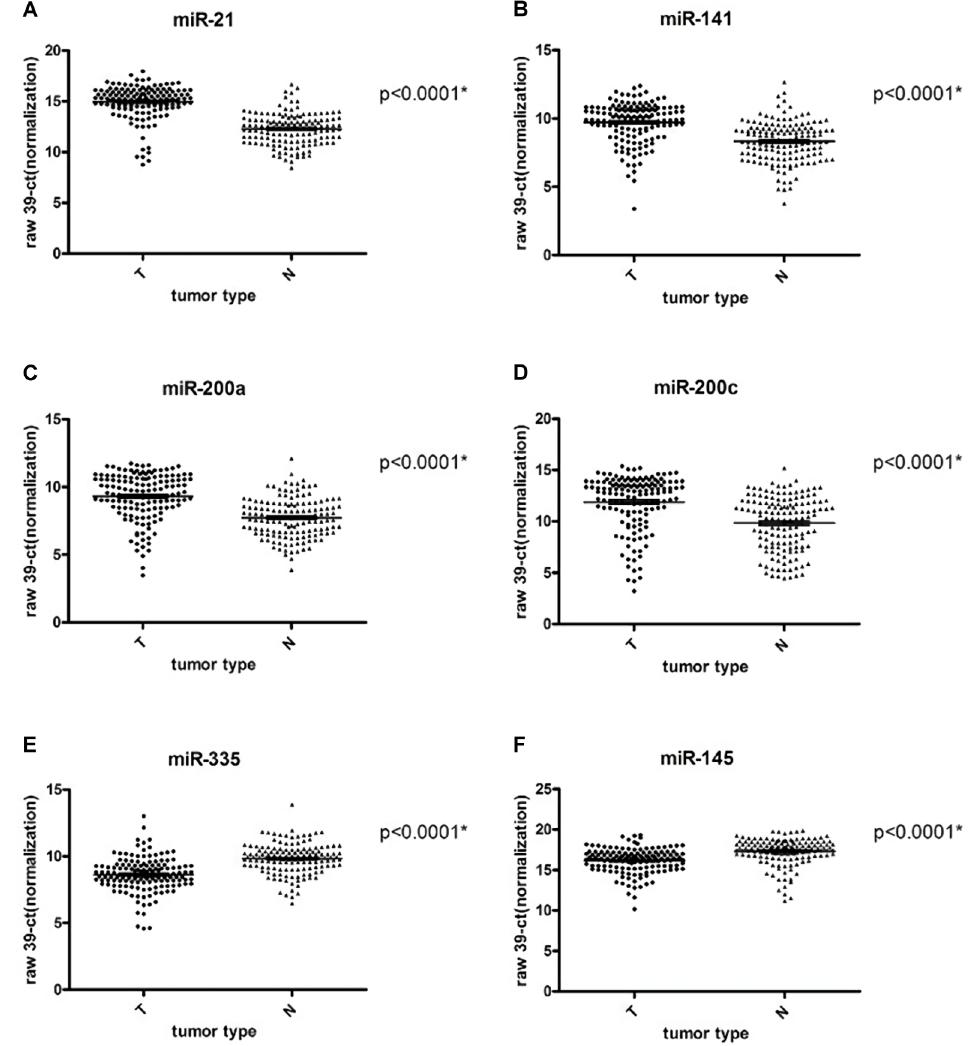
Fig 4. Dysregulated miRNAs between tumors and normal tissues. Up-regulated miRNAs: (A) miR-21, (B) miR-141, (C) miR-200a, (D) miR-200c; down-regulated miRNAs: (E) miR-335 and (F) miR-145 (tumor: n = 145; normal breast tissue: n = 140; (cid:3) significant by the t